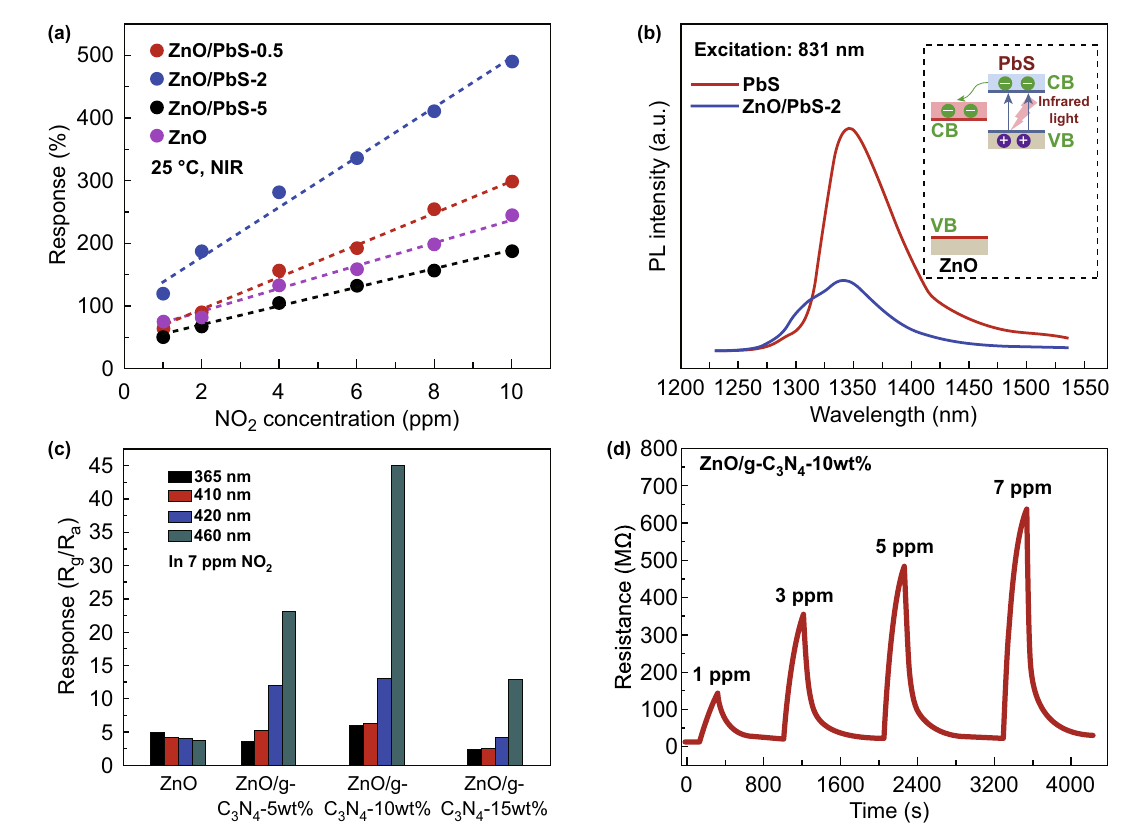
Fig. 3 a Responses of the sensors based on the ZnO/PbS nanocomposites with different PbS loading to 1–10 ppm of NO 2 under NIR illumina- tion at RT. b Photoluminescence spectra of PbS and ZnO/PbS-2 under 831 nm excitation. Reproduced with permission [37]. Copyright 2017, Elsevier. c Responses of ZnO/g-C 3 N 4 composites with various g-C 3 N 4 content to 7 ppm NO 2 under different wavelength light illumination. d Dynamic resistance curves of